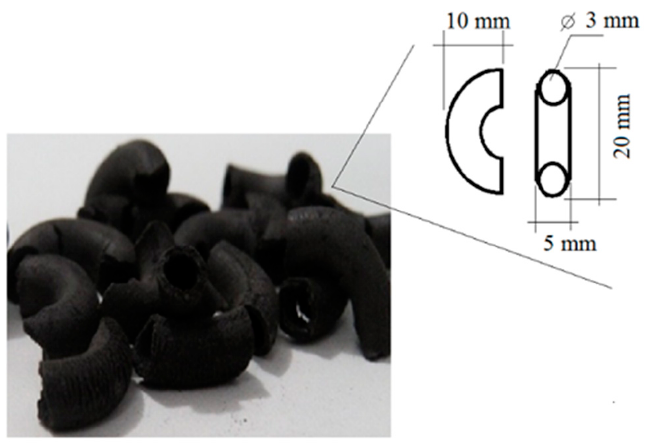
Figure 2. Geometric details of the catalysts K 2 CO 3 / γ -Al 2 O 3 /sepiolite/CoFe 2 O 4 prepared by extrusion procedure.